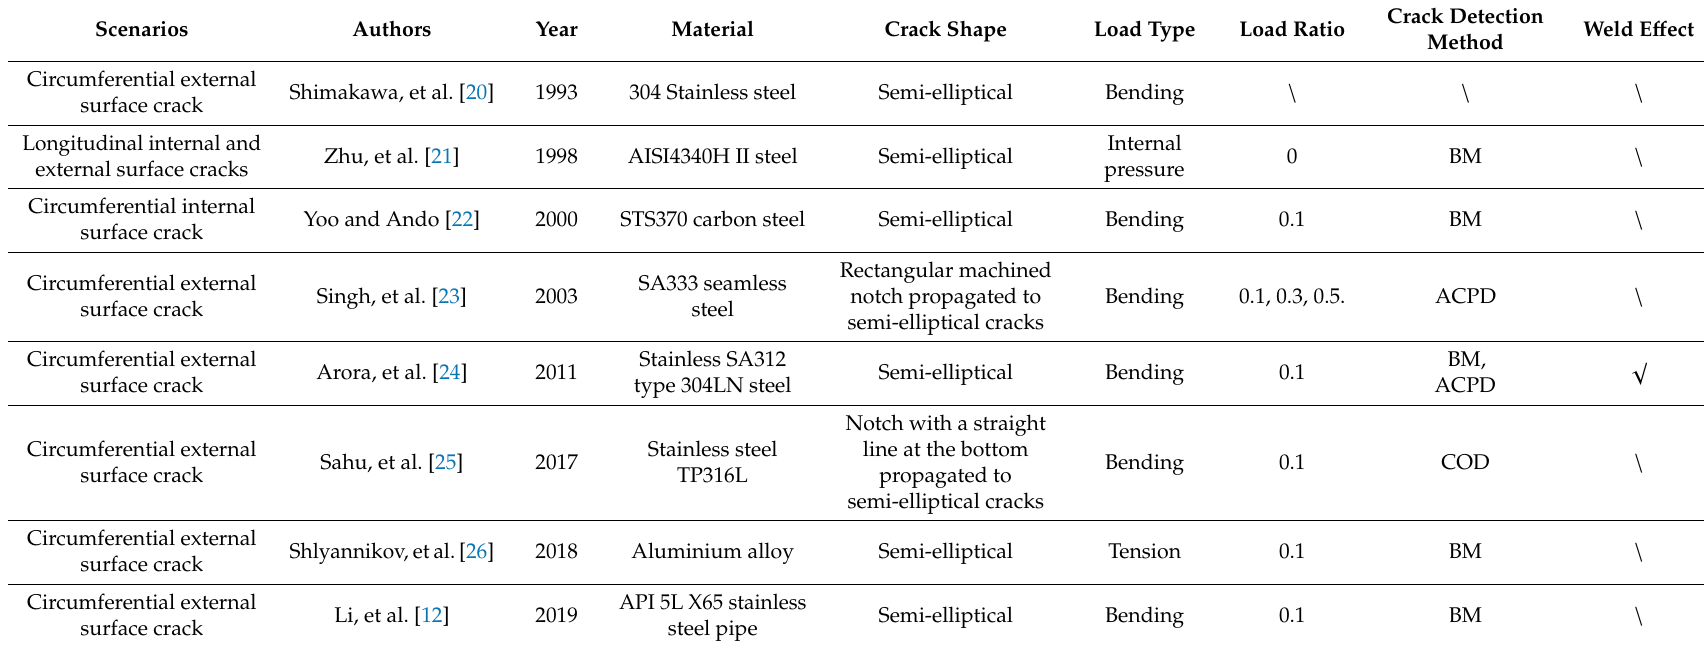
Table 2. The available experimental studies on surface crack growth in metallic